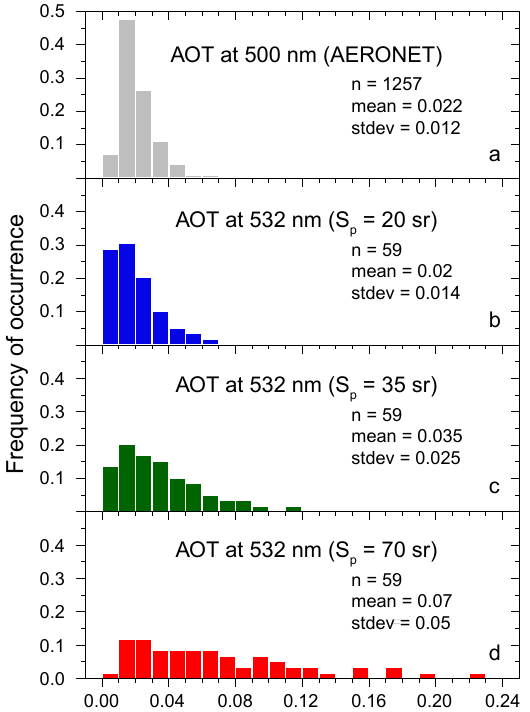
Figure 5. Frequency of occurrence of AOT from (a) AERONET sun photometer measurements at Rio Gallegos (level 2.0, 1257 cases), and (b–d) from Polly XT measurements at Punta Arenas (59 cases) for S P of 20, 35, and 70sr, representing clean marine, clean conti- nental, and smoke or polluted aerosol conditions, respectively, from 4 December 2009 to 4 April 2010.